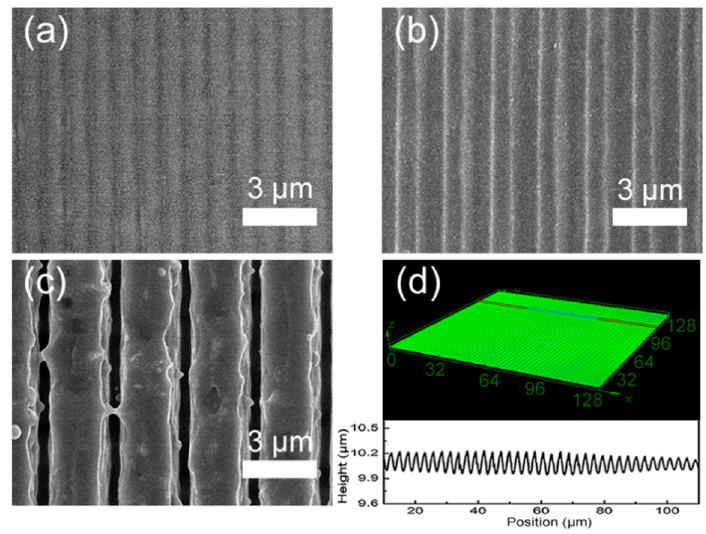
Figure 2. SEM photos of the micrograting with periods of ( a ) 1 µ m; ( b ) 2 µ m; ( c ) 3 µ m; ( d ) three- dimensional topography and cross-section morphology of micrograting with period of 3 µ m.